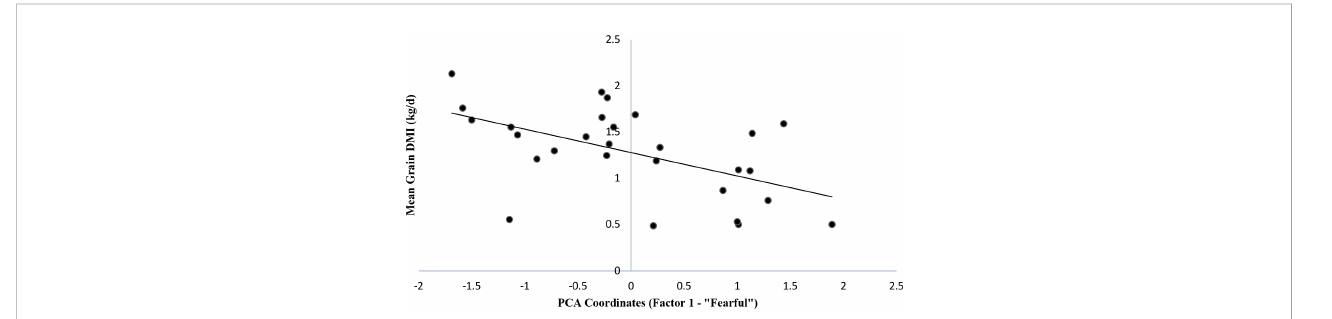
FIGURE 2 Average grain dry matter intake (DMI/d) of individually housed Holstein x Angus crossbred calves (n = 29) during the 76-d experimental period, plotted against Factor 1 ( “ Fearful ” ) from the principal component analysis of the standardized personality tests. Each black dot represents a calf, and the linear regression trendline is presented ( P <